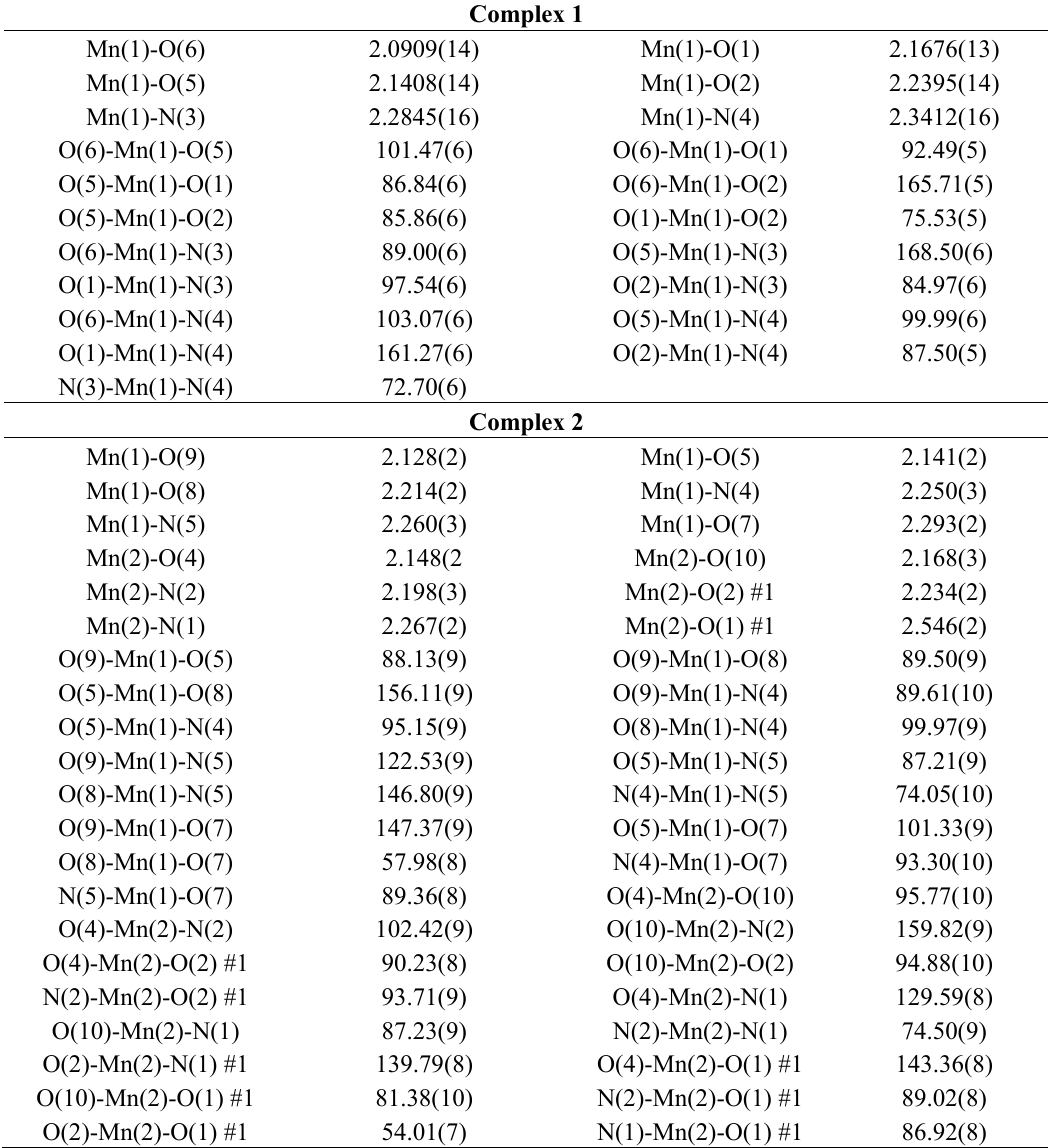
Table 2. Selected bond lengths (Å) and angles (°) for 1 – 2